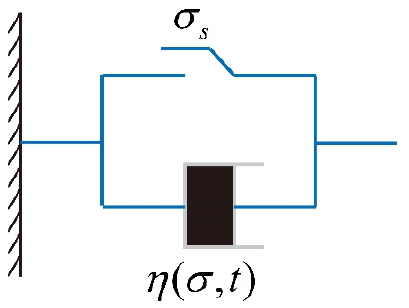
Figure 8. Nonlinear viscous-plastic element.